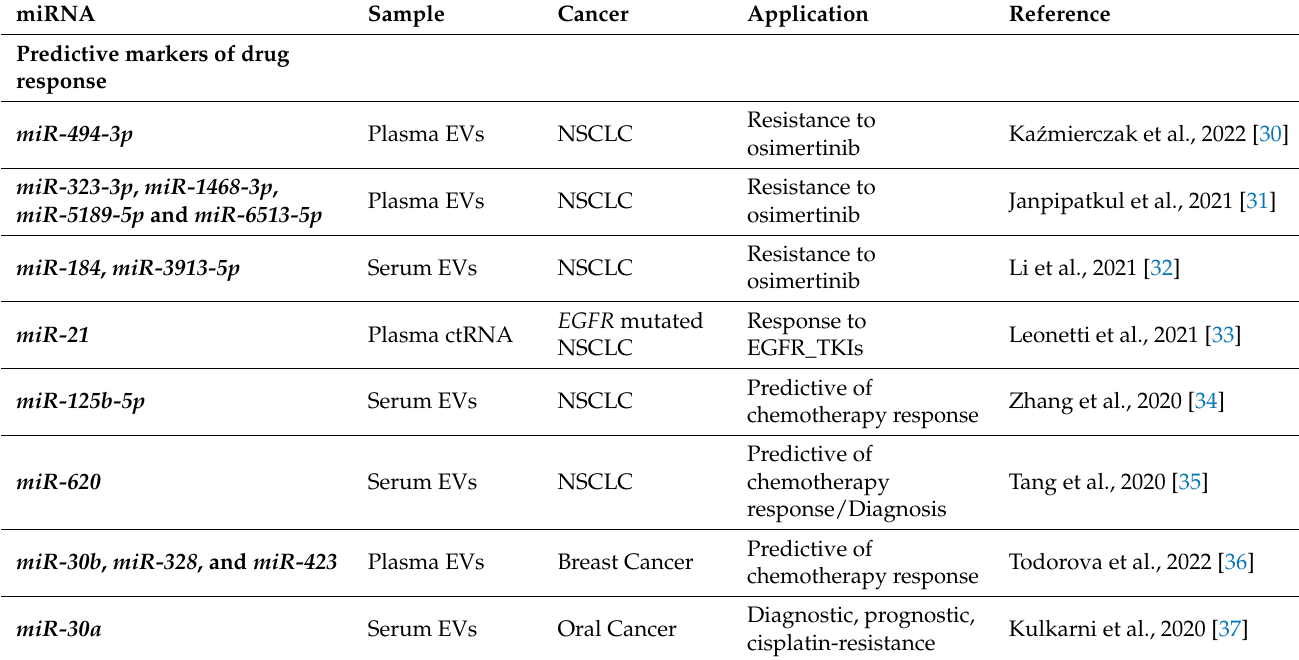
Table 1. Circulating extracellular-vesicles-associated miRNAs as potential cancer